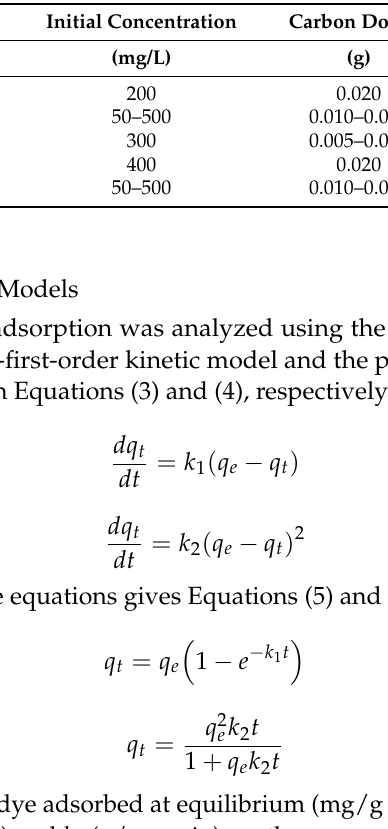
Table 1. Experimental conditions for the study of batch MB adsorption by longan seed-based activated